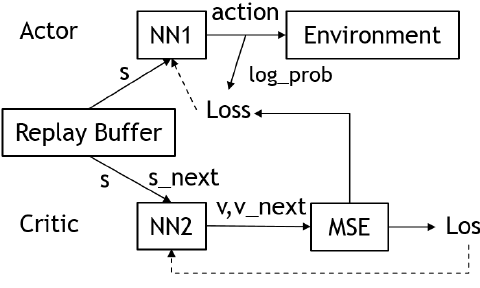
Figure 6. Flowchart of